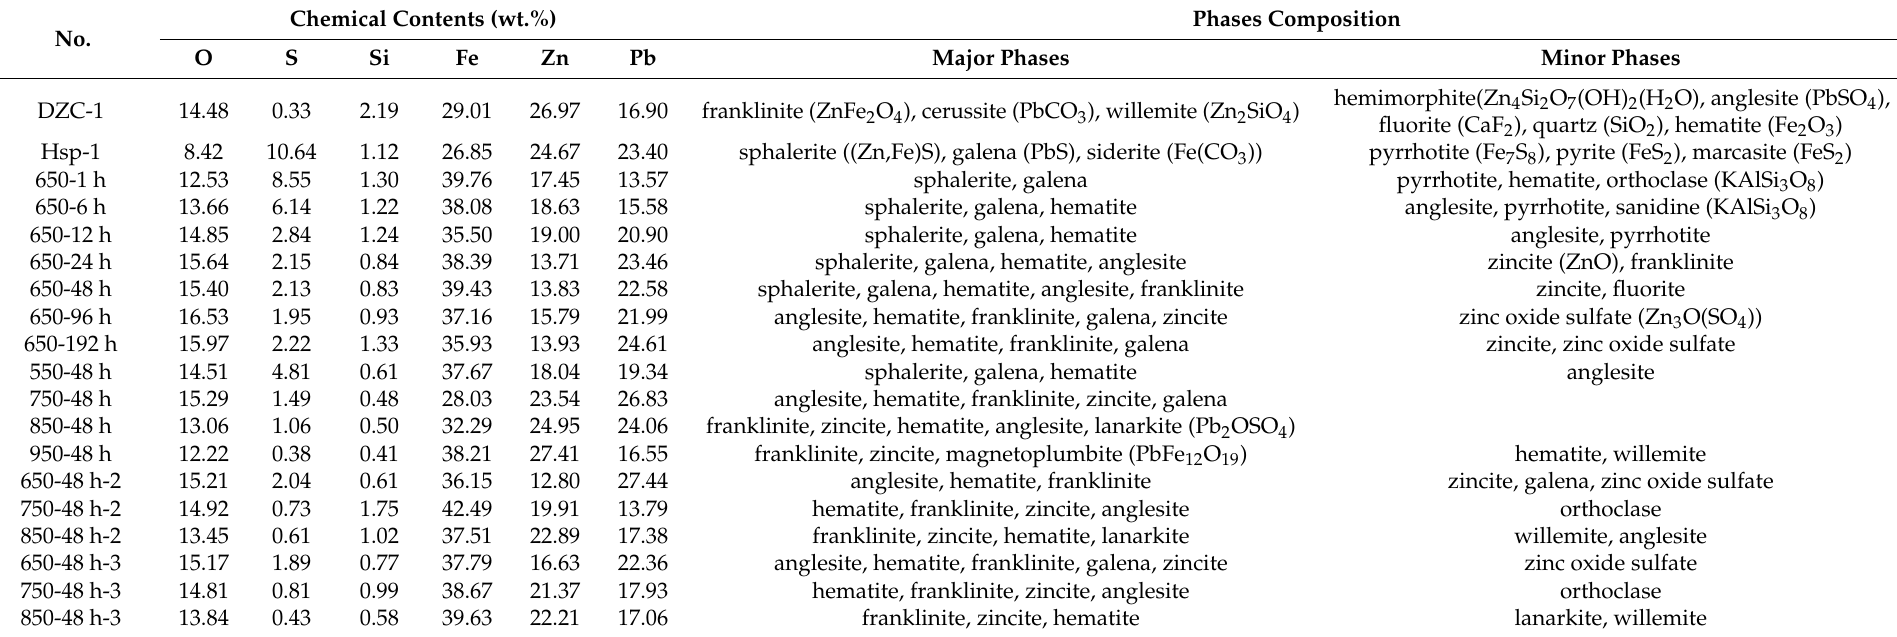
Table 1. The WDXRF and XRD analysis results of the unearthed zinc calcine, the ore used for the experiments, and the samples obtained under different experimental conditions.